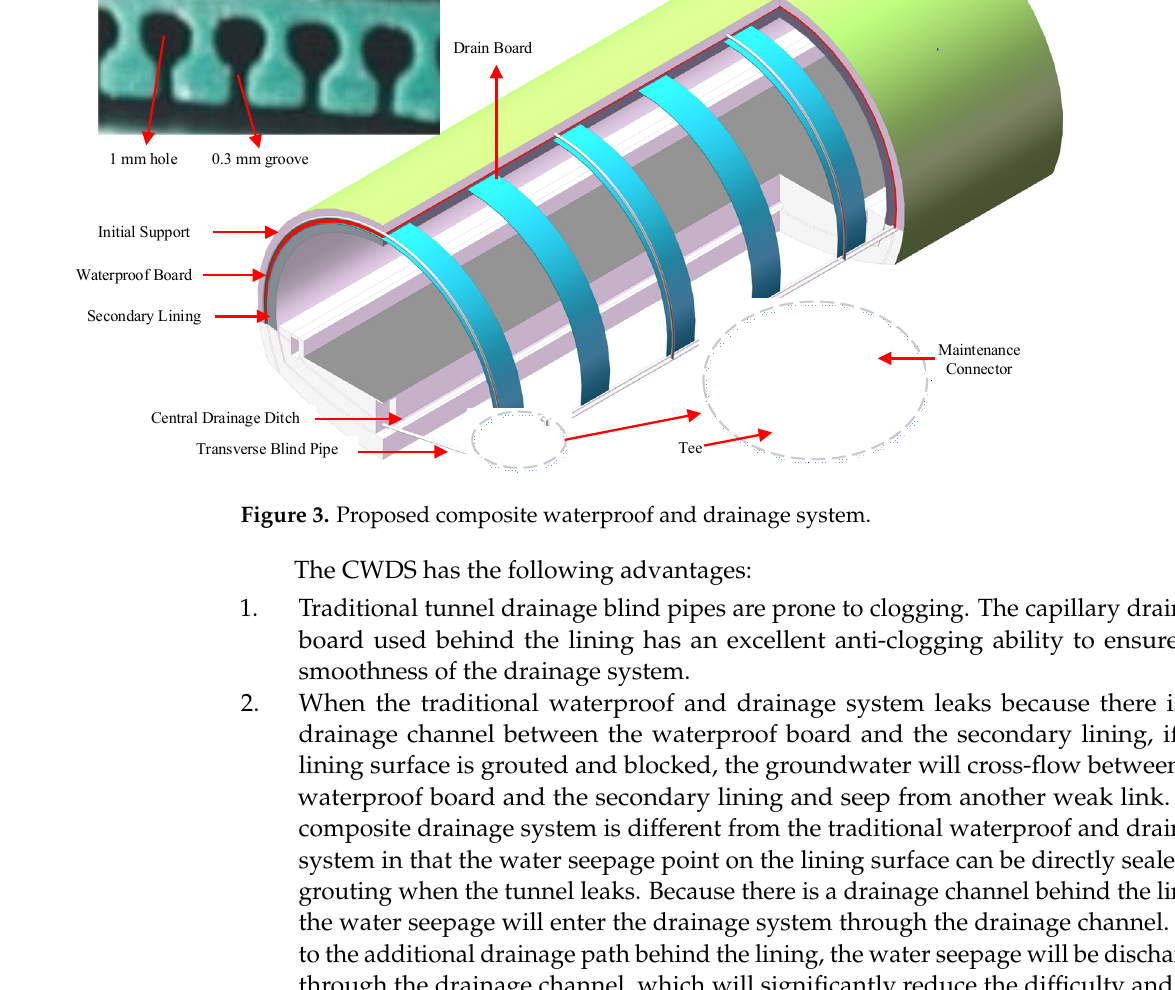
Figure 2. The diagram of tunnel deterioration. ( a ) water flow in the tunnel; ( b ) potential causes of deterioration; ( c ) leakage from the crack of section A.